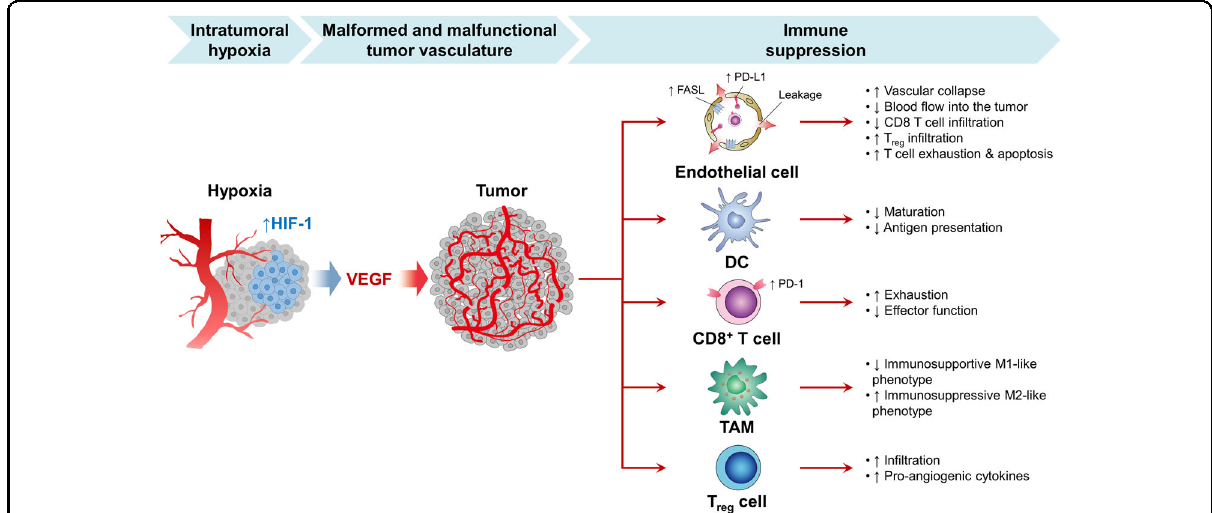
Fig. 1 The abnormal tumor vasculature elicits immune suppression in the tumor microenvironment. Tumor cells rapidly outgrow their blood supply, leading to hypoxia and acidosis in the tumor microenvironment (TME), which in turn promotes immunosuppressive mechanisms. Hypoxia stimulates HIF-1 and thereby upregulates VEGF. VEGF induces tumor angiogenesis, resulting in the malformed and malfunctional vasculature. Tumor endothelial cells exhibit immunosuppressive characteristics, such as PD-L1 expression, which enhance the exhaustion and apoptosis of T cells. Dendritic cell (DC) maturation is suppressed, resulting in interruption of T cell priming by impaired antigen presentation. In addition, TOX-mediated transcriptional reprogramming severely exhausts CD8 + T cells. Furthermore, tumor-associated macrophages (TAMs) polarize from an immunosupportive M1-like phenotype to an immunosuppressive M2-like phenotype. Regulatory T (T reg ) cells also accumulate within the TME to promote tumor